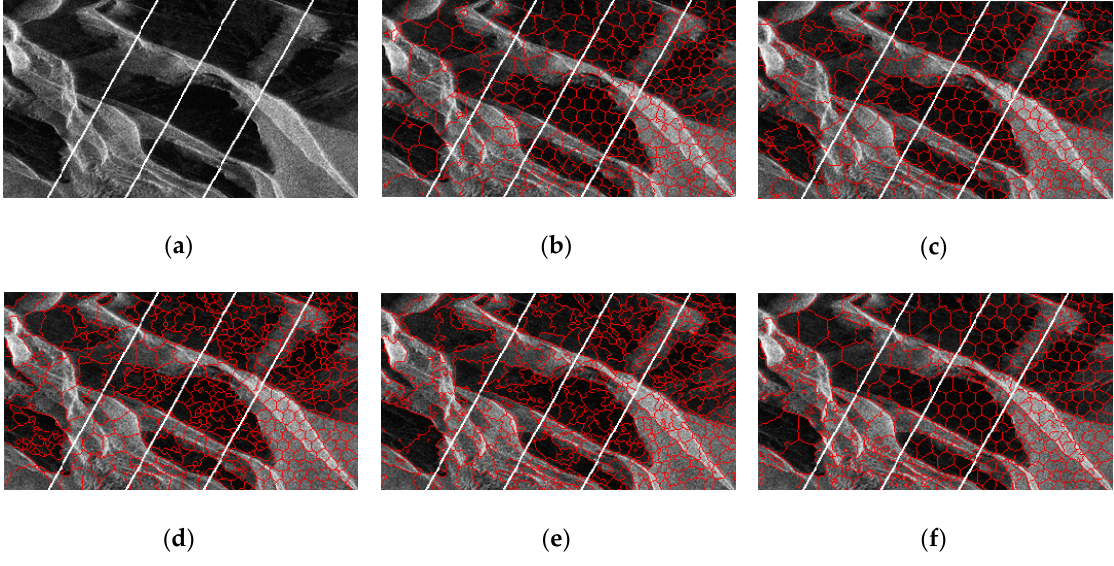
Figure 19. Resulting superpixels of Antarctica with m set to six and K set to 100, 200, 400, and 600 for regions A, B, C, and D. ( a ) Original SAR image; ( b ) SLIC; ( c ) PILS; ( d ) LBSLIC; ( e ) PBSLIC; and ( f ) PSDSD.